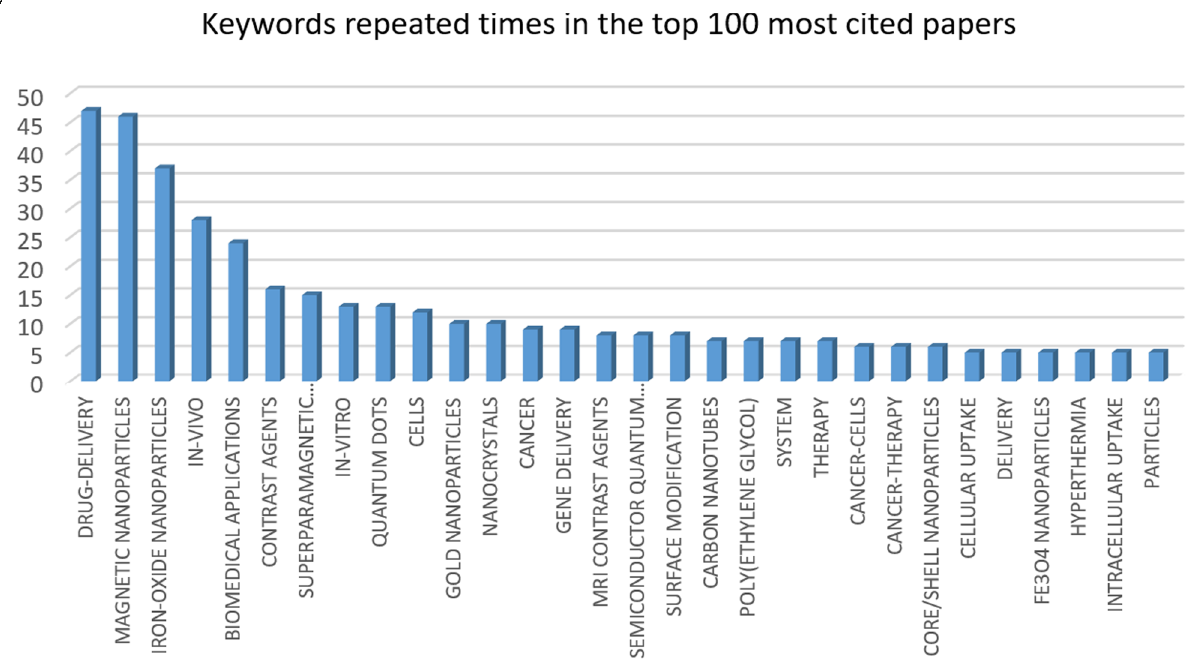
Fig. 7 Keywords sorted by the number of articles